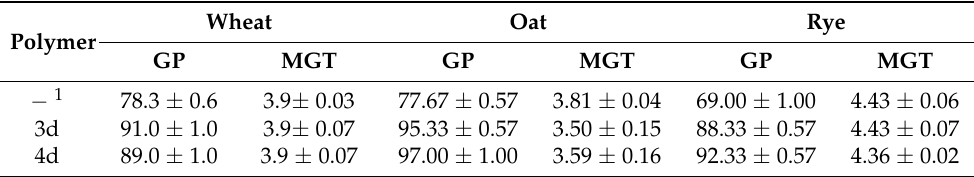
Table 5. Germination parameters of some crops in solutions of silatrane polymers.